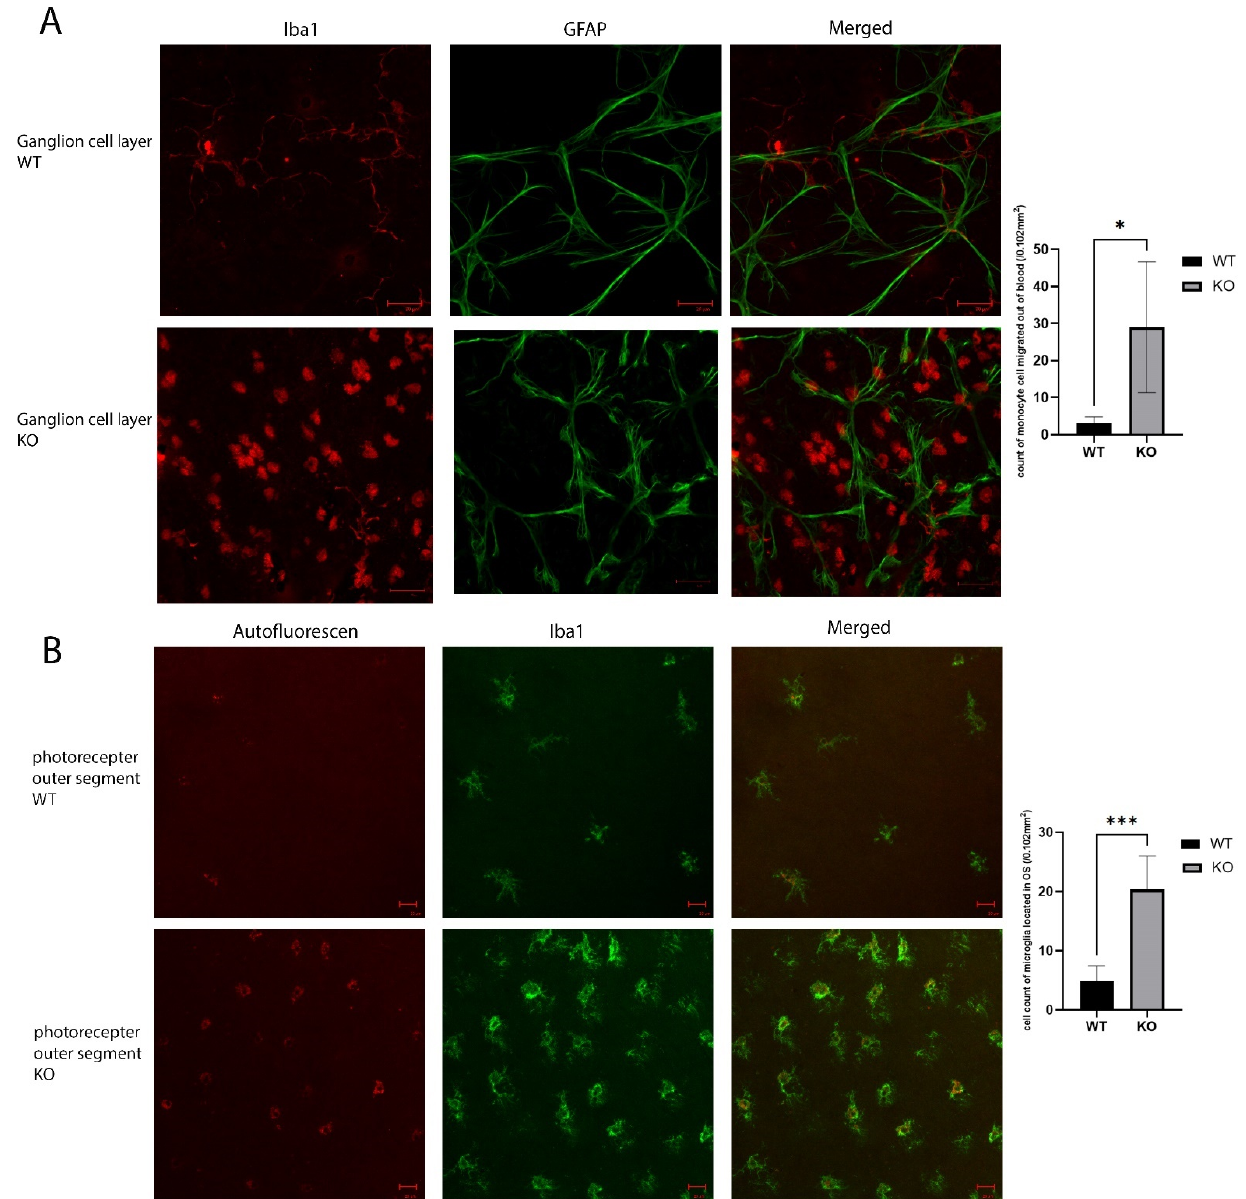
Figure 5. Inflammatory reaction in the KO vs. WT mice. ( A ). Immunolabeling of retinal astrocyte processes for GFAP and microglia for Iba1 in the ganglion cell layer of the retinal flat mounts showed infiltration by monocytes (the round Iba1 positive cells) in the ganglion cell layer. ( B ). Iba1 immunolabeling shows increased activated microglia cells in the photoreceptor outer segments layer. Scale bar: 20 µm. 10 WT and 10 KO mice were analyzed for each study. * p < 0.05, *** p < 0.001.